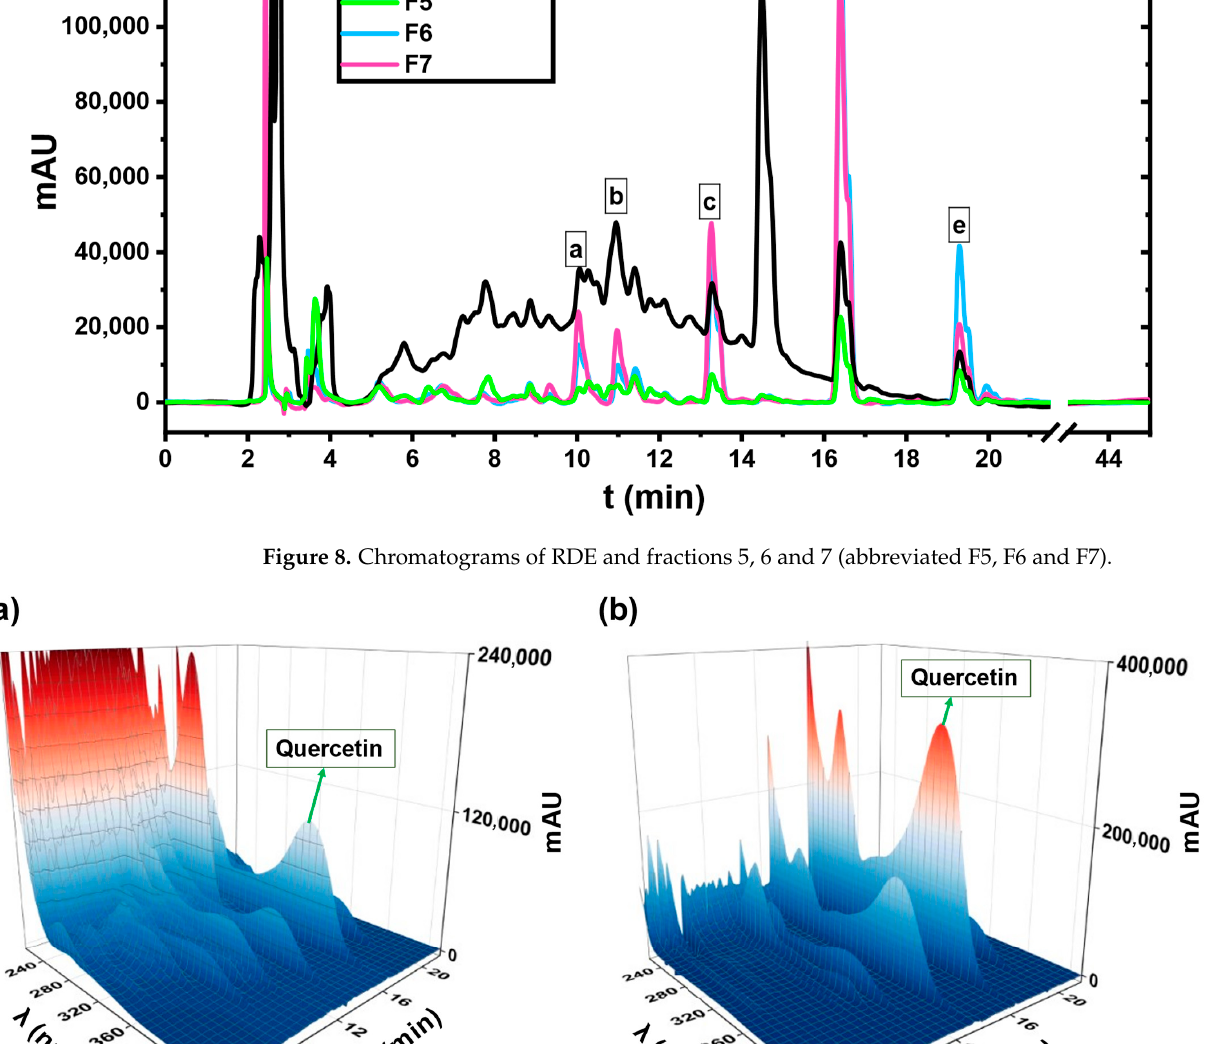
Figure 9. Three-dimensional chromatograms: ( a ) RDE extract; ( b ) fraction 7.